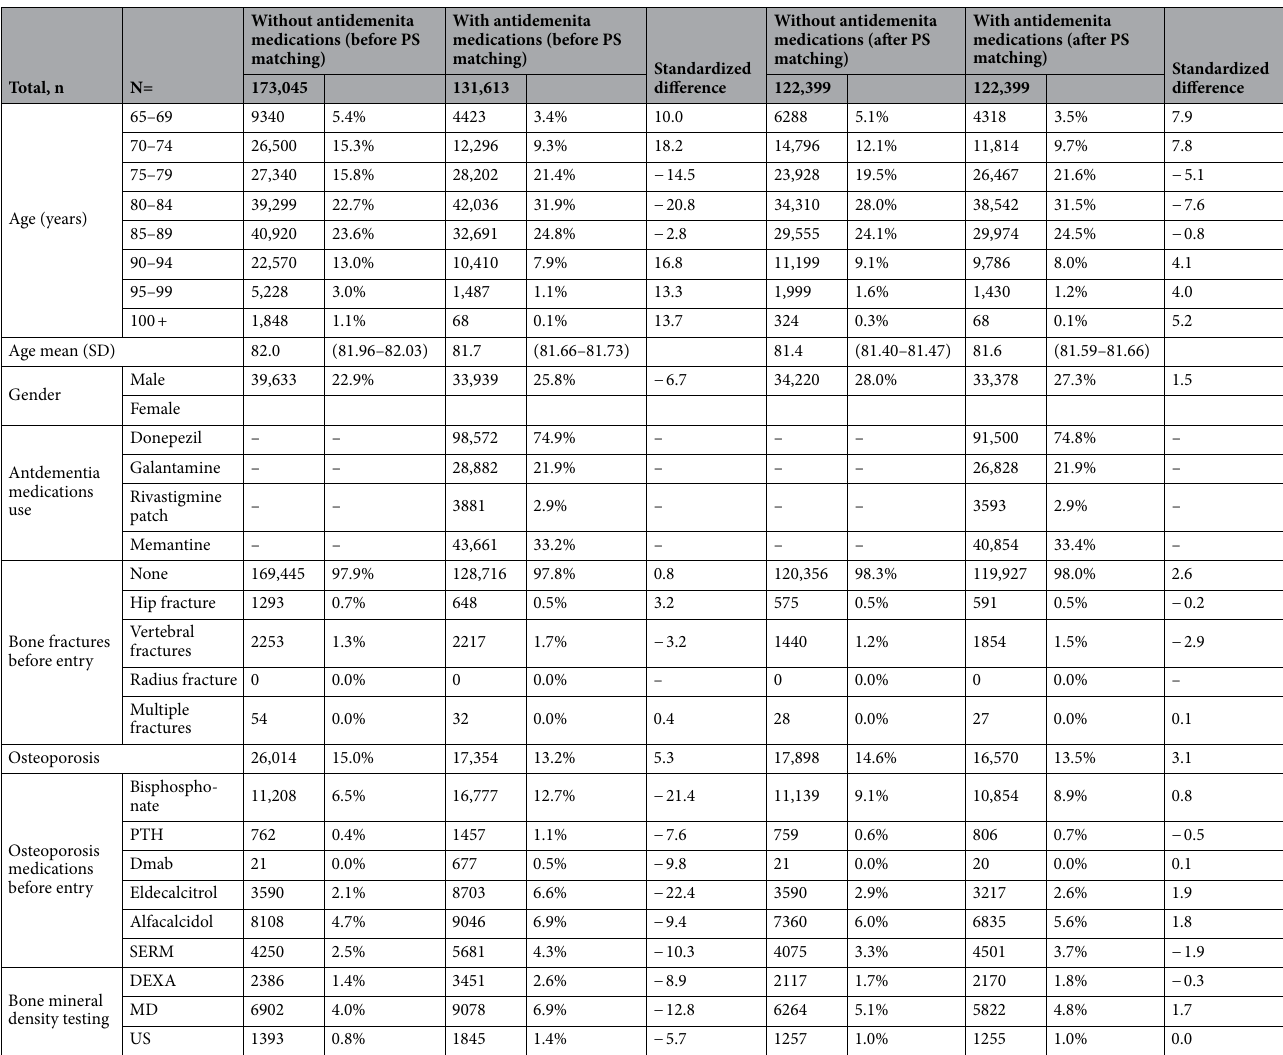
Table 2. Baseline characteristics of AD group with and without antidementia medications. AD Alzheimer’s dementia, SD standard deviation.